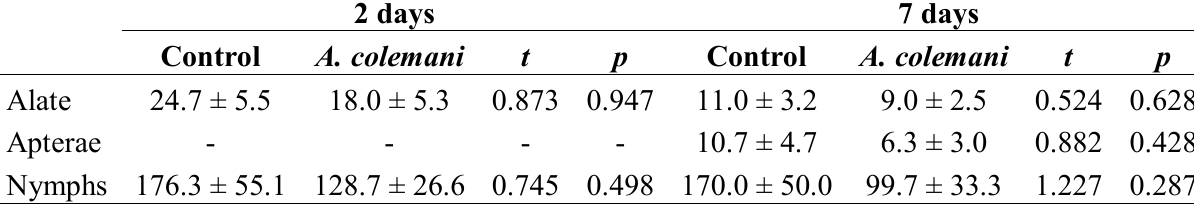
Table 1. Mean ± S.E. density (number of individuals/plant) of adult morphs and nymphs in the CMV-infected virus source plant after 2 and 7 days in cages with and without (control) A. colemani followed by statistics according to Student’s t test ( p < 0.05).